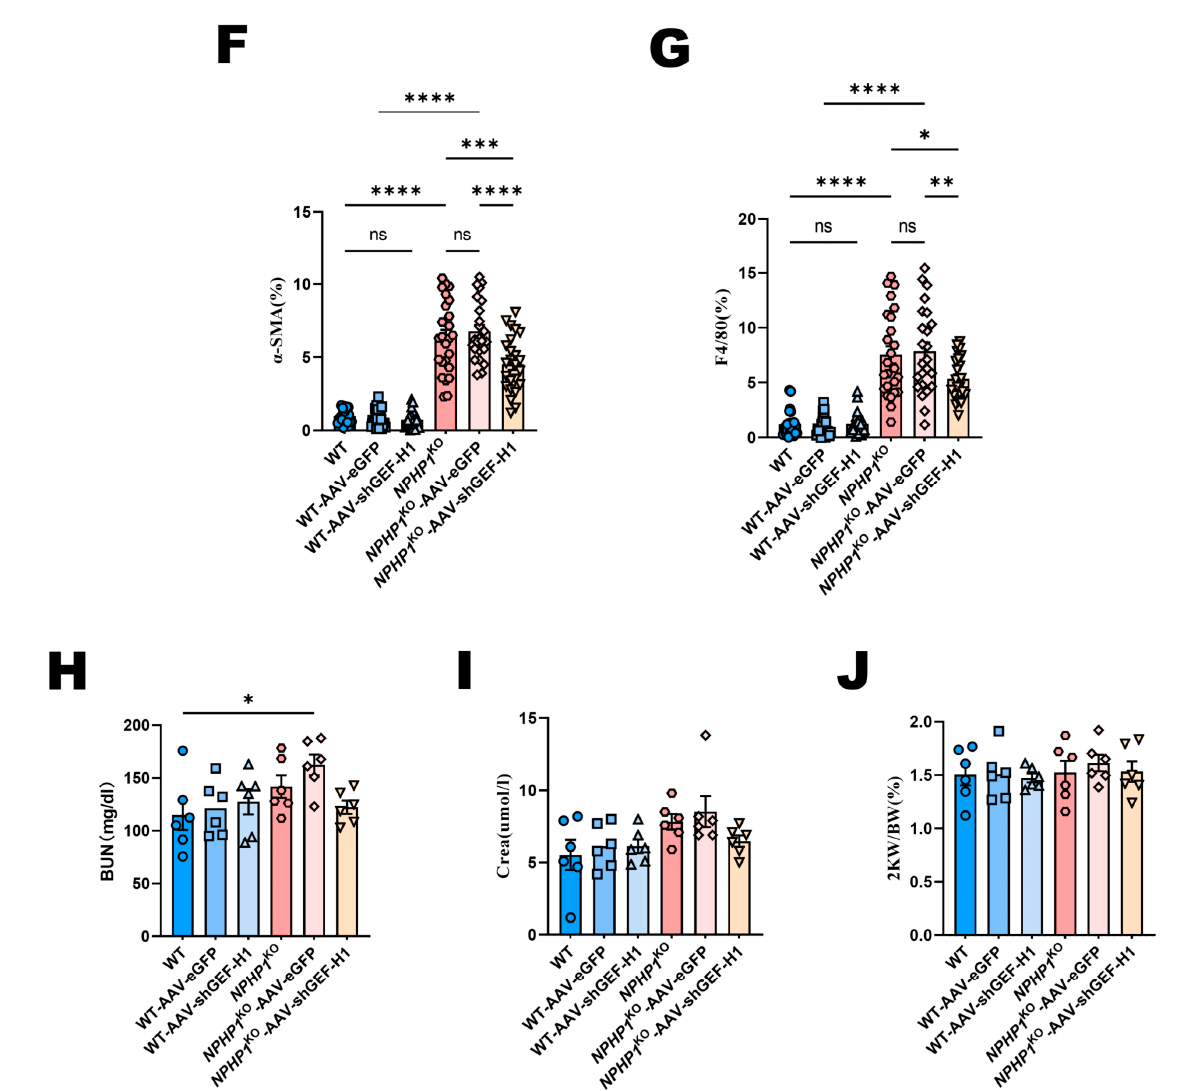
Figure 3. GEF-H1 knockdown alleviated renal interstitial inflammation and fibrosis in NPHP1 KO mice compared with WT mice. ( A , C ): Renal histology of mice from different groups. Asterisks indi- cate cysts, and black arrows indicate inflammatory cells. ( A ): HE staining, ( C ): Masson’s trichrome staining; scale bar = 200 µ m). ( B ): Quantitative analysis of the number of inflammatory cells from a × 200 magnified image (8 images/mouse) ( n = 6 mice/group). ( D ): Quantification of renal fibrosis by Masson staining of interstitial collagen. Each dot represents the percentage of staining of a × 200 mag- nified image (4–5 images/mouse) from n = 6 mice/group. Scale bar = 200 µ m. ( E ): Immunostaining of the macrophage biomarker F4/80 (yellow) and myofibroblast biomarker α -smooth muscle actin ( α -SMA, red). The increased F4/80 cell and α -SMA in the NPHP1 KO mice, which indicated renal interstitial inflammation and fibrosis, were then decreased after being transfected with AAV-shGEF- H1. Scale bar = 200 µ m. ( F , G ): Quantification of F4/80 and α -SMA staining. Each dot represents the percentage of staining of a × 200 magnified image (4–5 images/mouse) from n = 6 mice /group. Scale bar = 200 µ m. ( H ): Blood urea nitrogen (BUN) level ( n = 6 mice/group). ( I ): Creatinine (Crea) level ( n = 6 mice/group). ( J ): Bilateral kidney weight (2KW) / body weight (BW) ratio ( n = 6 mice/group). Data represent the mean ± SEM. * p < 0.05; ** p < 0.01; *** p < 0.001; **** p < 0.0001; ns, no